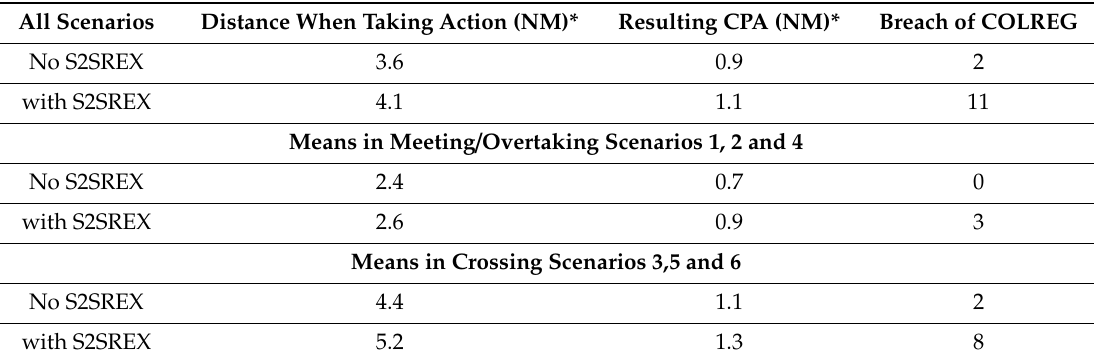
Table 4. Numerical analysis of baseline and experimental